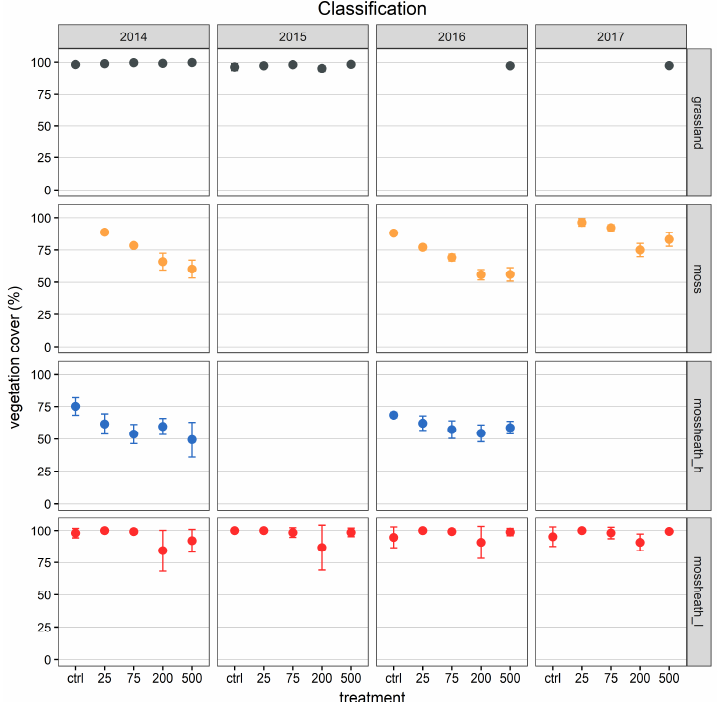
Figure 4. Vegetation cover (%) of healthy, undamaged vegetation derived from the MLC for the four experimental plots (i.e., grassland, moss, highland moss-heath (mossheath_h), and lowland moss-heath (mossheath_l)). Data is shown for four years (2014 until 2017) and five treatments classes (i.e., control (ctrl), 25, 75, 200, 500 passes). The points indicate the mean over the replicates, while the error bar indicates one standard deviation from the mean .